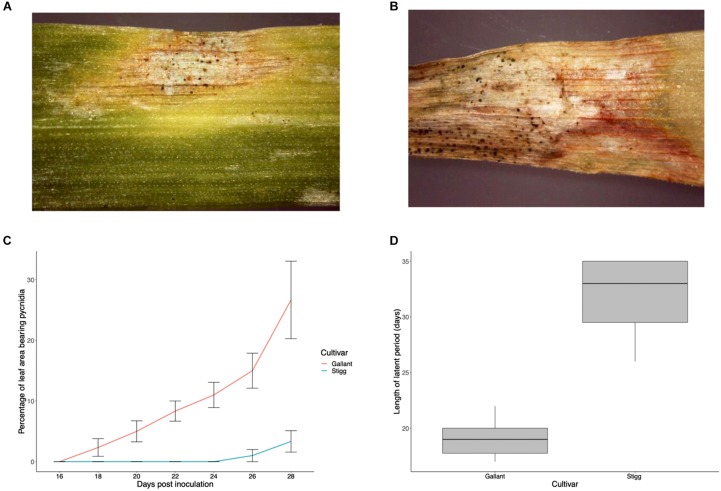
Development of Septoria tritici blotch disease on wheat cultivars Stigg and Gallant. (A,B) Representative photograph of cv. Stigg and cv. Gallant at 28 dpi. (C) Means of percentage necrotic areas bearing pycnidia for disease scores on the second leaf from day 17–28 dpi. (D) Boxplot of Latency period in cv, Gallant and Stigg. Latency period was calculated as days from inoculation to first appearance of lesions bearing pycnidia. If pycnidia were not detached on replicates by day 35, these samples were given a value of day 35 (10 biological replicates per time point per treatment per cultivar were measured per trial and 3 trials were conducted). Bars indicate SEM.